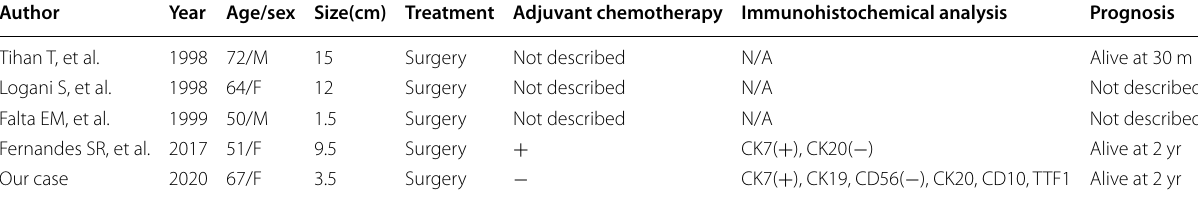
Table 1 Reported cases of clear cell type intrahepatic cholangiocarcinoma